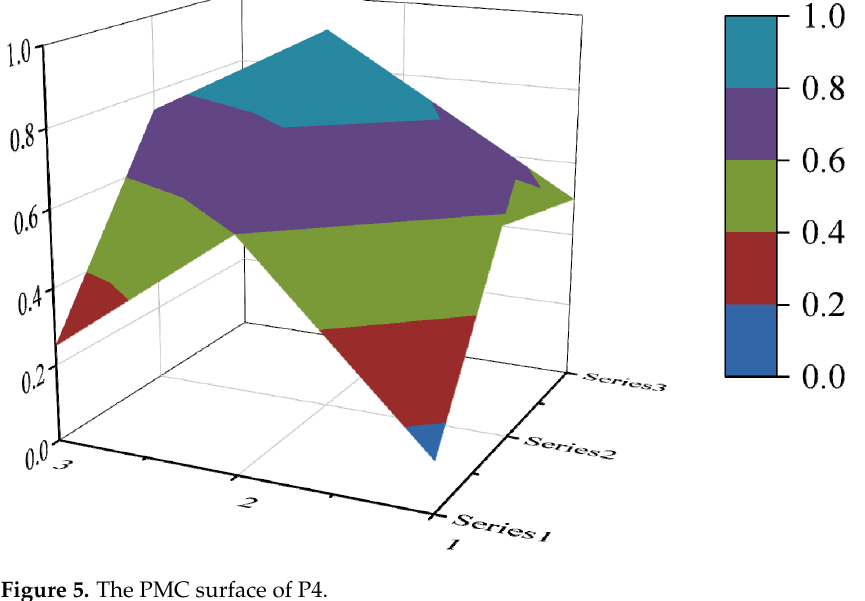
Figure 5. The PMC surface of P4.